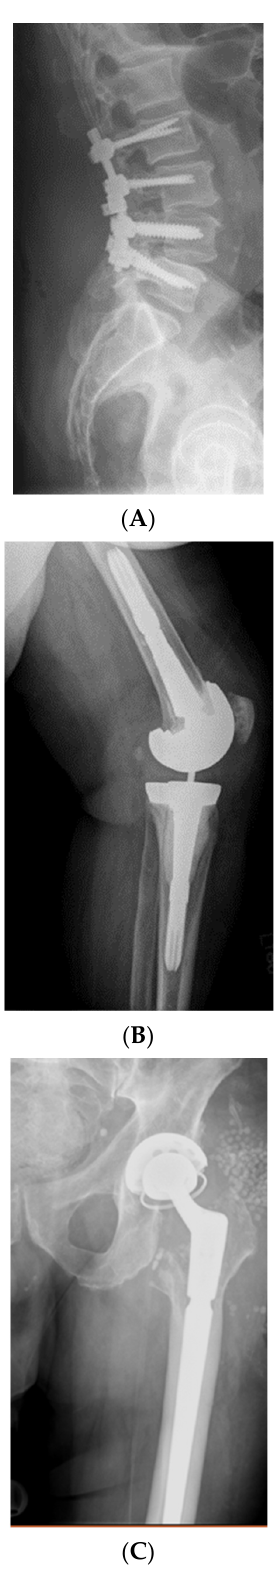
Figure 1. Examples of a few types of “hardware” that once infected require removal for definitive cure of these biofilm infections. ( A ) A lumbar posterior spinal rods and pedicle screw construct. ( B ) Total knee arthroplasty with long stem femoral and tibial components. ( C ) Total hip arthroplasty.